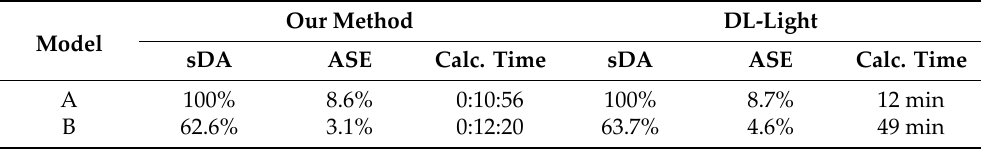
Table 7. Comparison of our method and DL-Light.